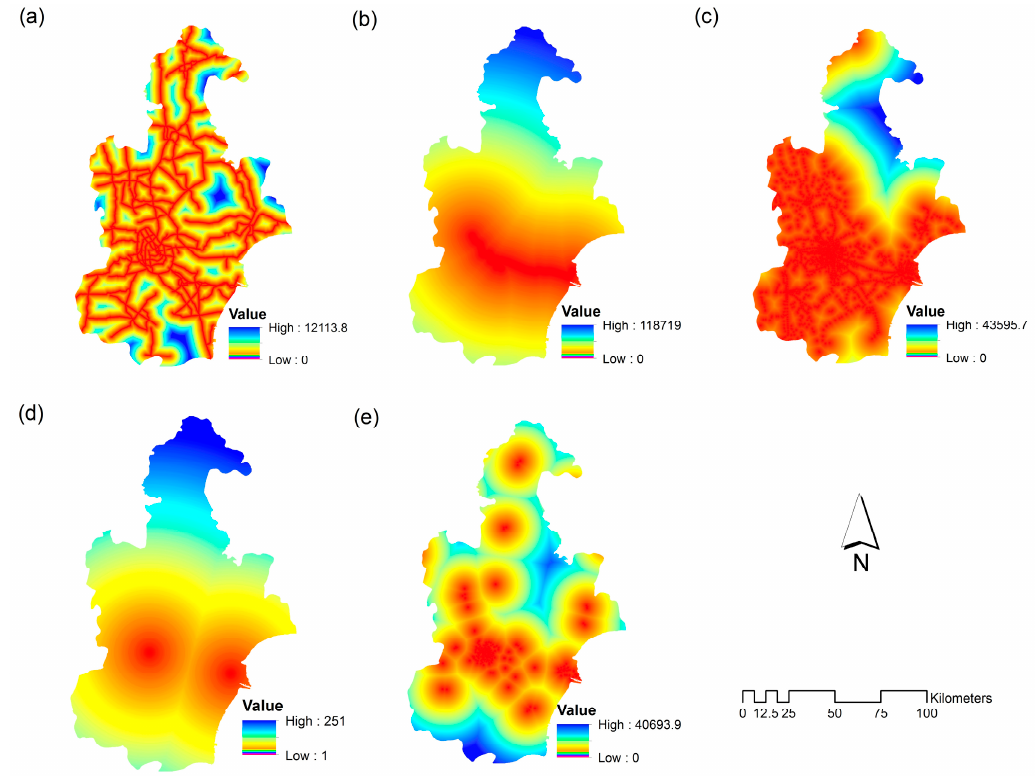
Figure 2. Spatial patterns of five variables: ( a ) distance to roads; ( b ) distance to subways; ( c ) distance to the capital bus stations; ( d ) distance to CBDs; ( e ) distance to markets.